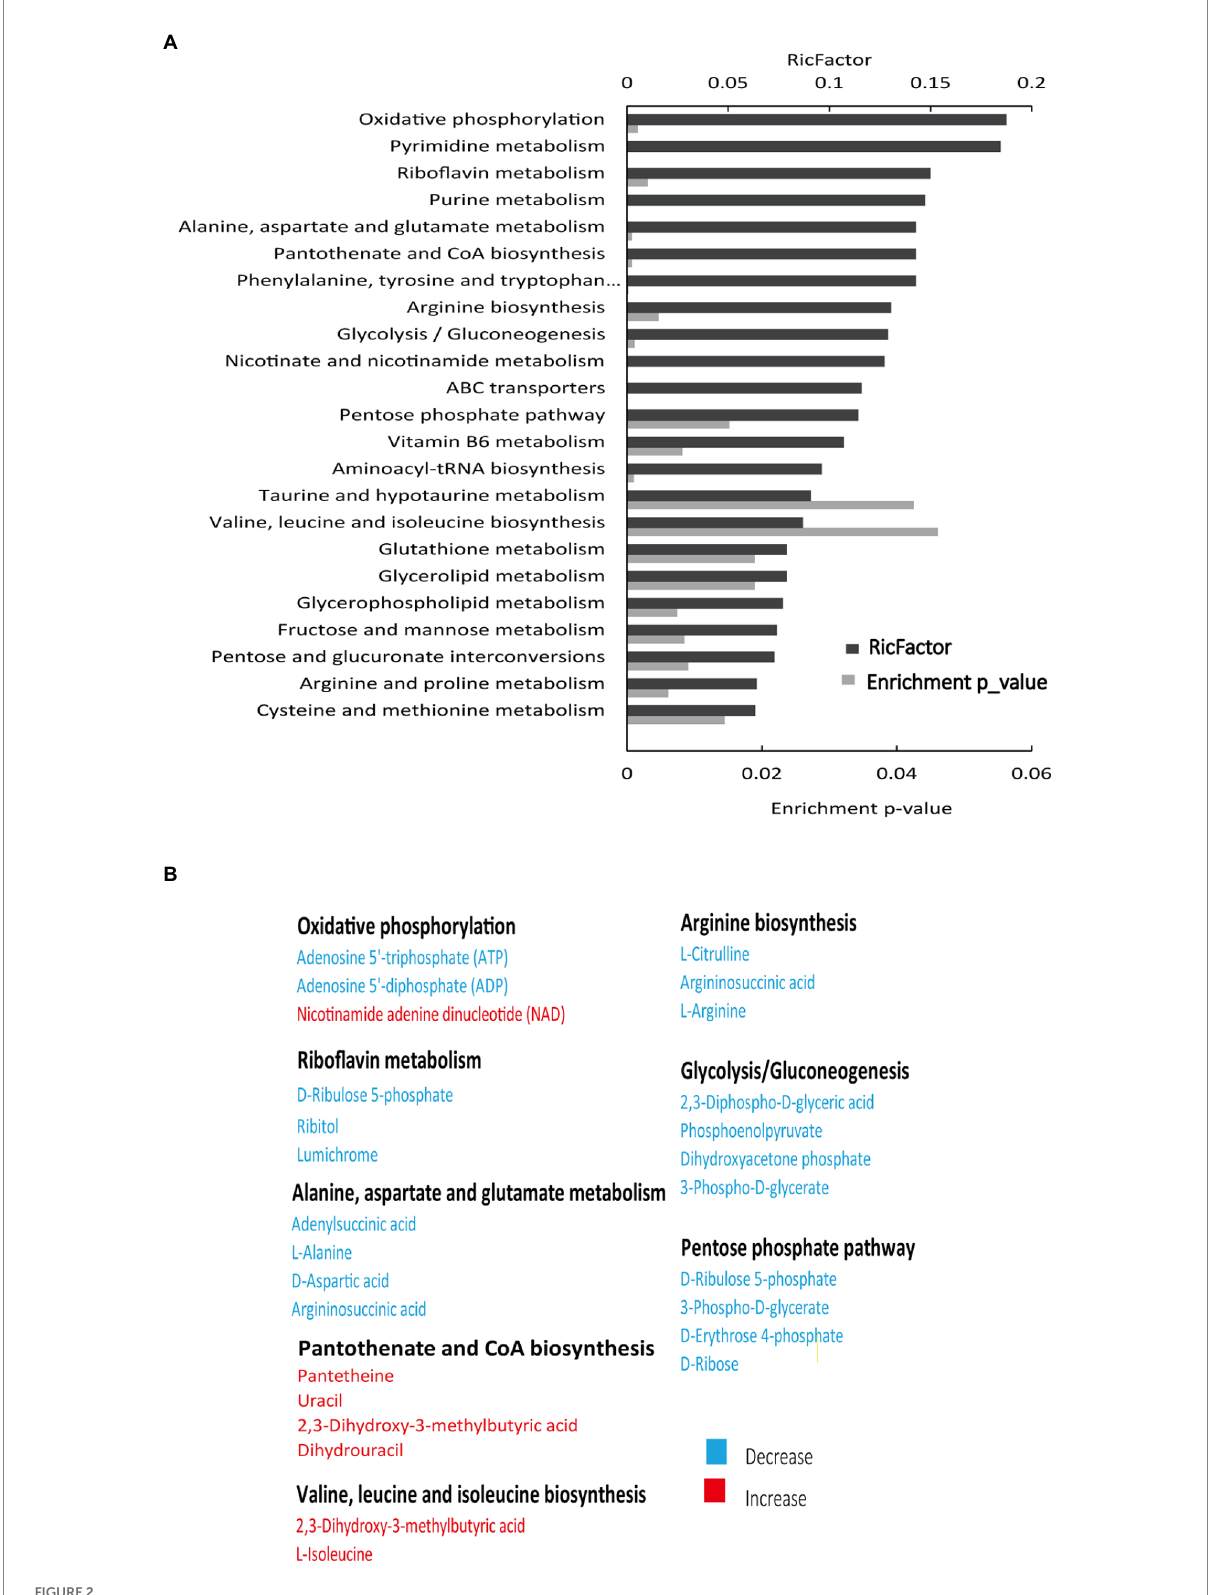
FIGURE 2 Enriched pathways in SCH-R. (A) Pathway enrichment of metabolites in SCH-R and SCH-S. (B) Differential expression of metabolites from important metabolic pathways. Red color indicates increased metabolite levels; Blue color indicates decreased metabolite